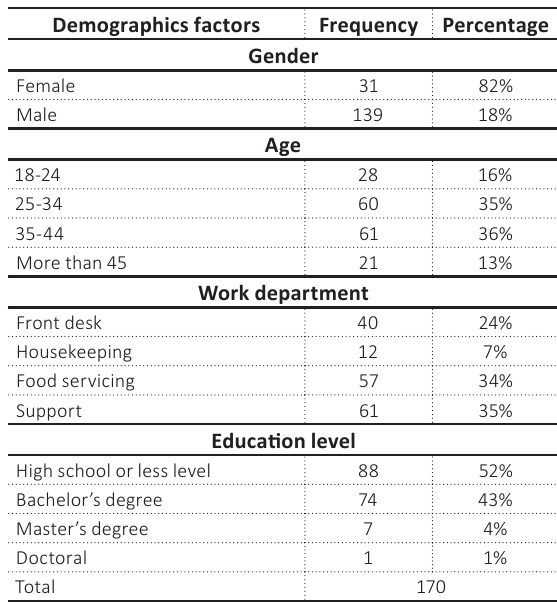
Table 1. Demographics of